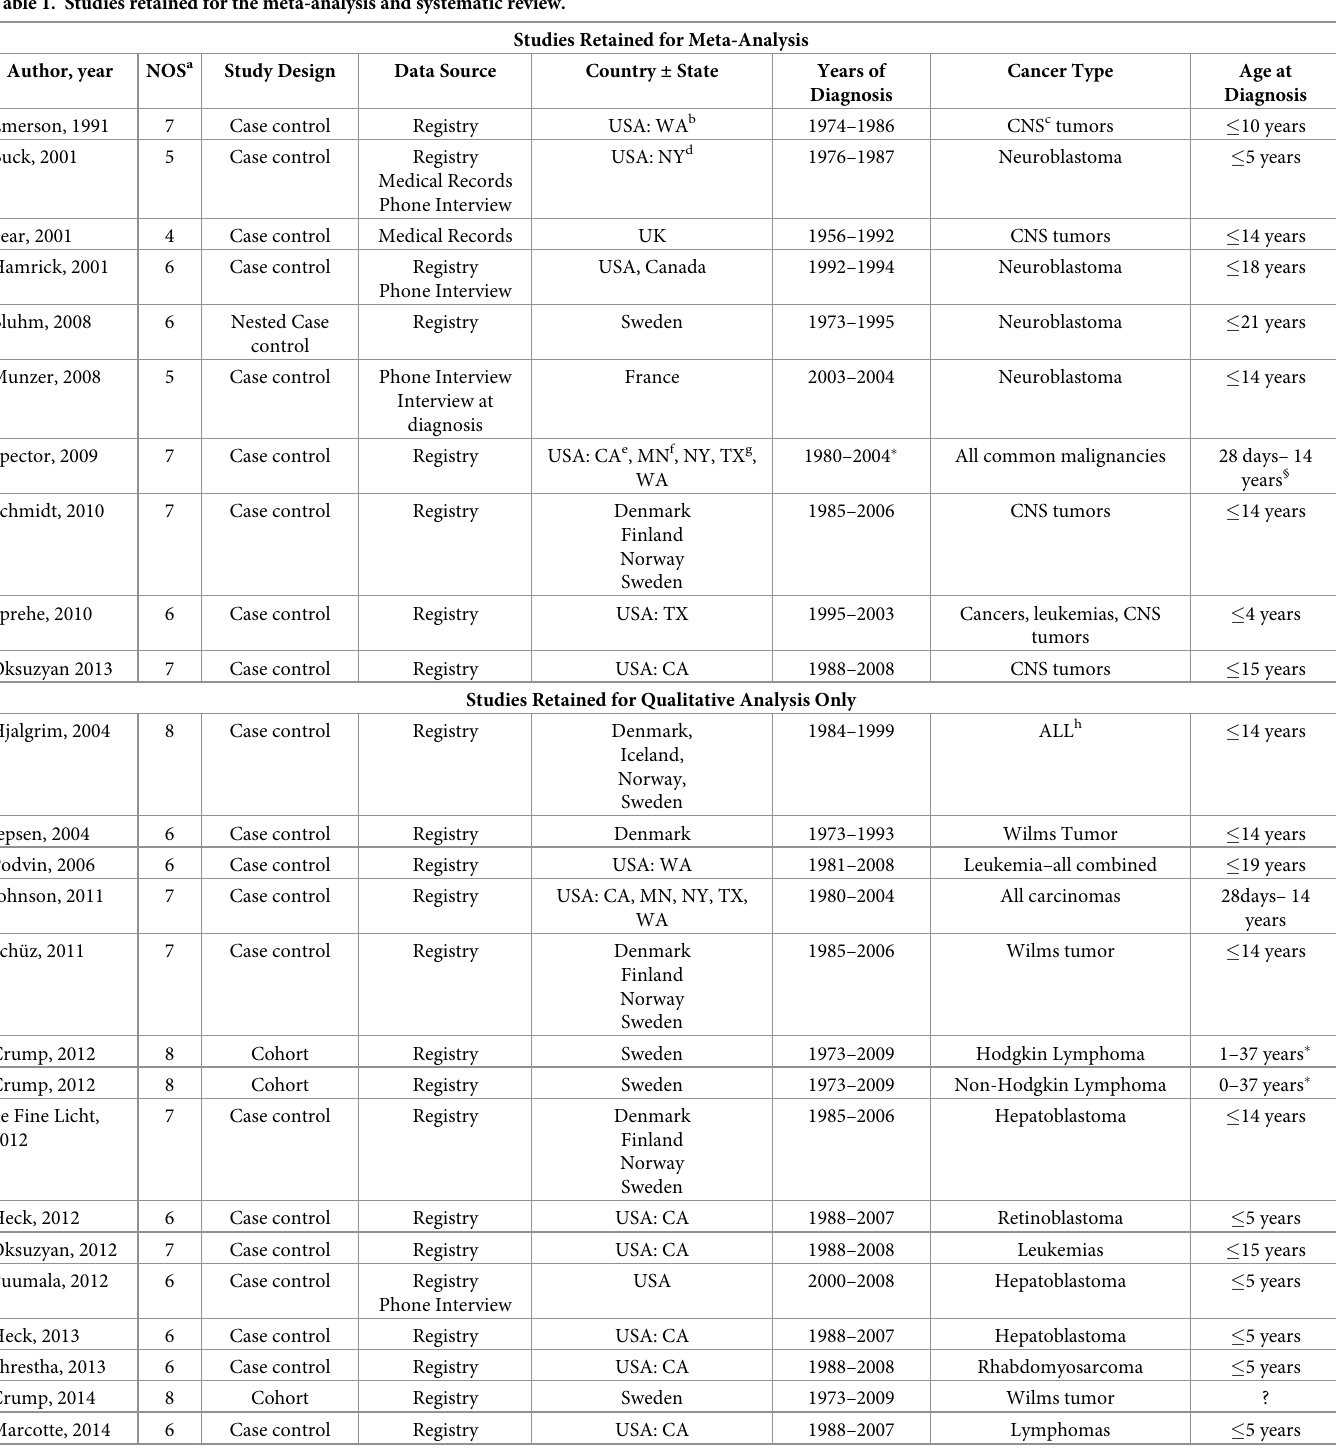
Table 1. Studies retained for the meta-analysis and systematic